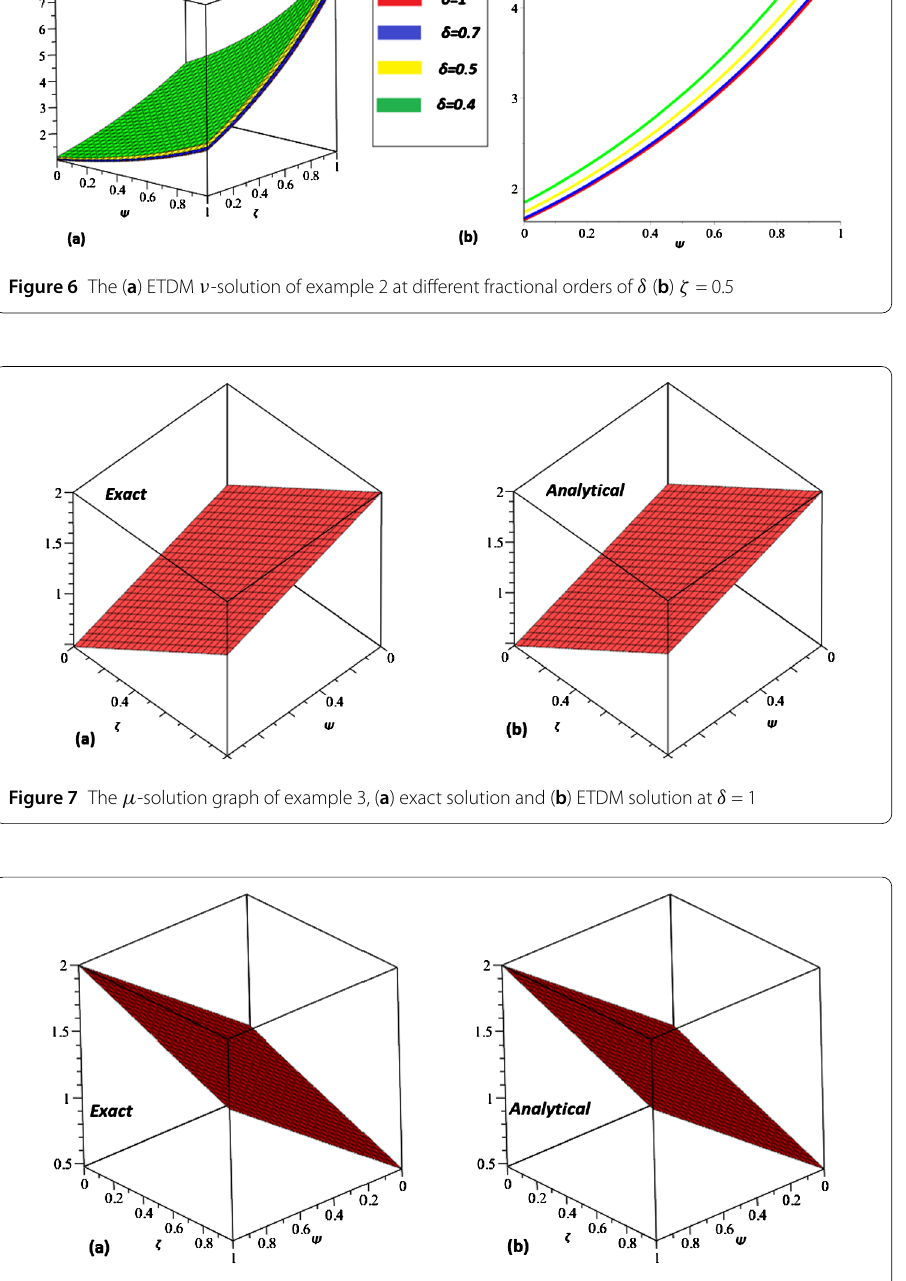
ETDM and exact solutions of example 3. Similarly in Fig. 11, the ETDM error is analyzed and solution at different fractional-orders are presented in two-dimensional graph for ex- ample 3. Tables 1 and 2, represent the exact, ETDM and the associated ETDM absolute error of example 1 at δ = 1 for μ and ν variables respectively. Both Tables 1 and 2